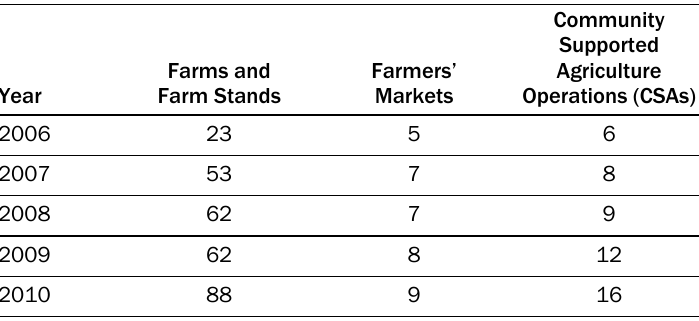
Table 1. Summary of the Increase in Local Food Providers in